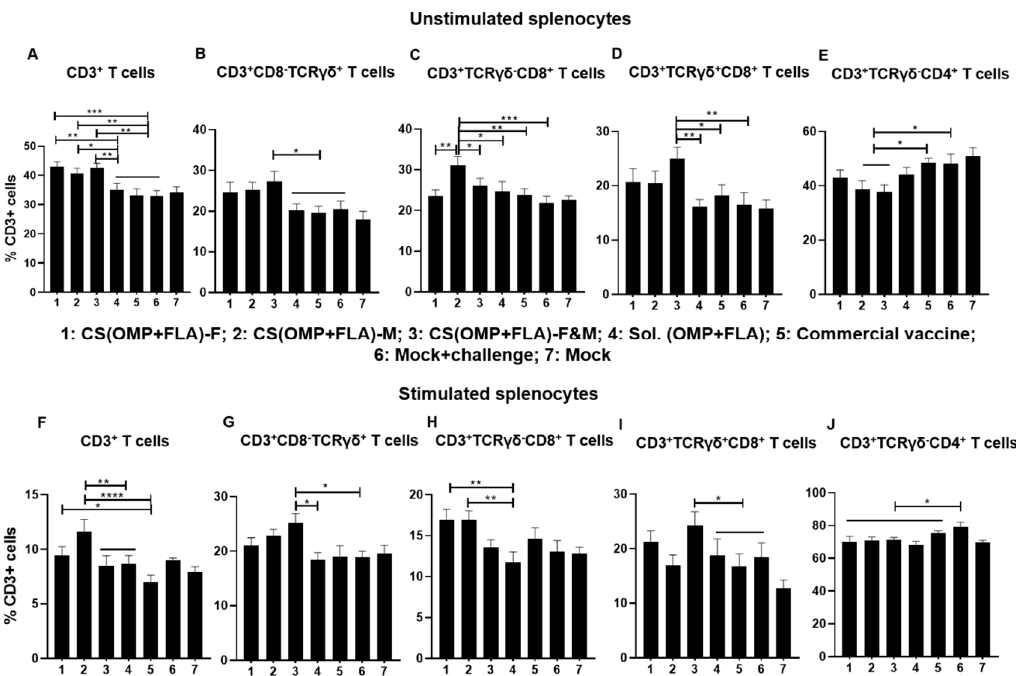
Figure 4. Recall frequencies of various lymphocyte subsets in the spleens of vaccinated and challenged broilers. Splenocytes isolated on the day of necropsy were analyzed for the frequencies of unstimulated and SE (OMP+FLA) antigen-stimulated lymphocyte subsets by flow cytometry. The frequency of ( A + F ) CD3 + T cells; ( B + G ) CD3 + CD8 - TCR γδ + T cells; ( C + H ) CD3 + TCR γδ - CD8 + T cells; ( D + I ) CD3 + CD8 + TCR γδ + T cells; and ( E + J ) CD3 + TCR γδ - CD4 + T cells. Data are presented as the average percentage of indicated splenocyte subset ± SEM of 6 to 13 birds per group. Significant differences were determined by one-way ANOVA followed by Tukey post-hoc test between each of the groups. Only significant differences are labelled in the figures (* p < 0.05, ** p < 0.01, *** p < 0.001, and **** p < 0.0001).